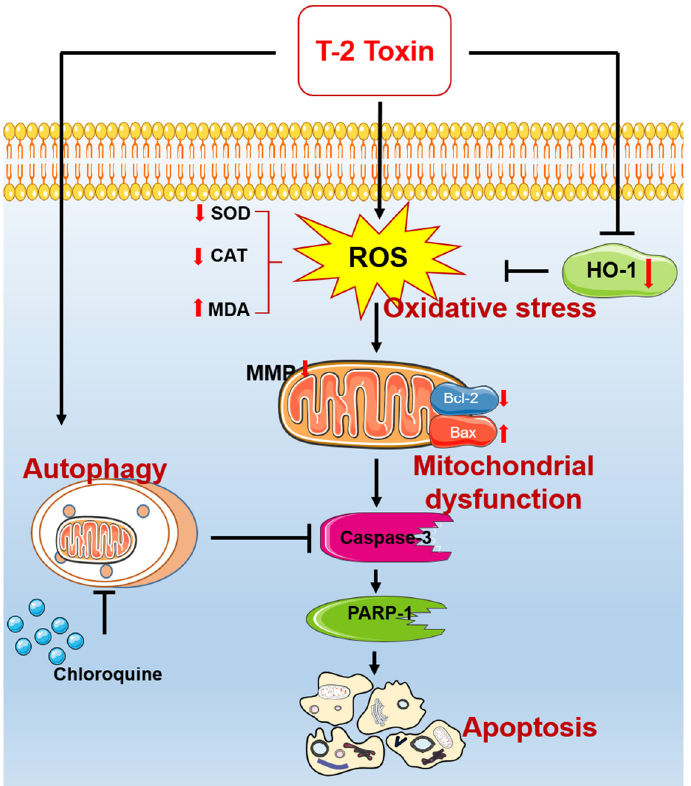
Figure 8. Schematic diagram of the proposed mechanisms of T-2 toxin-induced apoptosis in mouse microglia BV2 cells. ROS, reactive oxygen species; MMP, mitochondrial membrane potential; PARP-1, poly (ADP-ribose) polymerase-1; MDA, malondialdehyde; CAT, catalase; SOD, dismutase; HO-1, heme oxygenase-1.